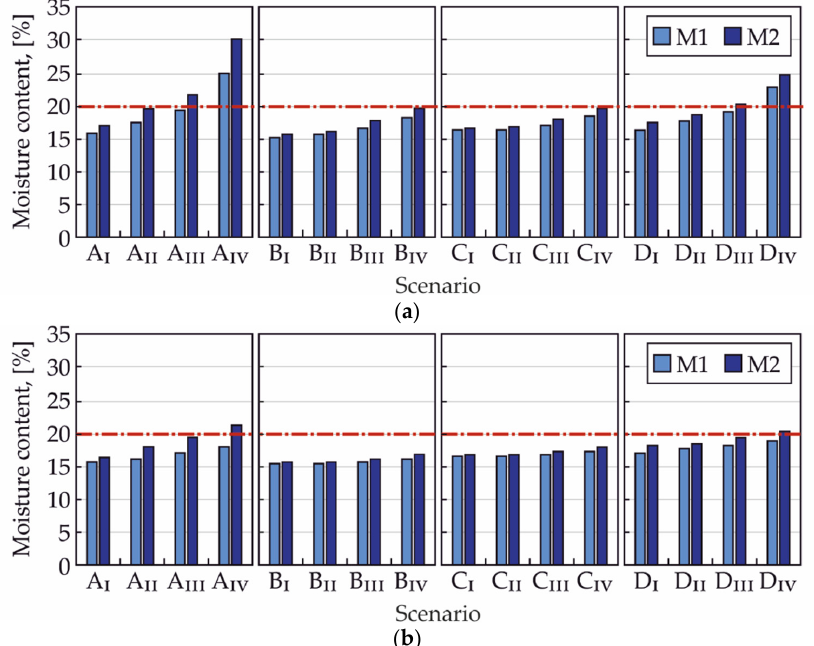
Figure 7. Maximal moisture content for OSB (M1 and M2) for ACH = 3 h − 1 ( a ) and ACH = 9 h − 1 ( b ).